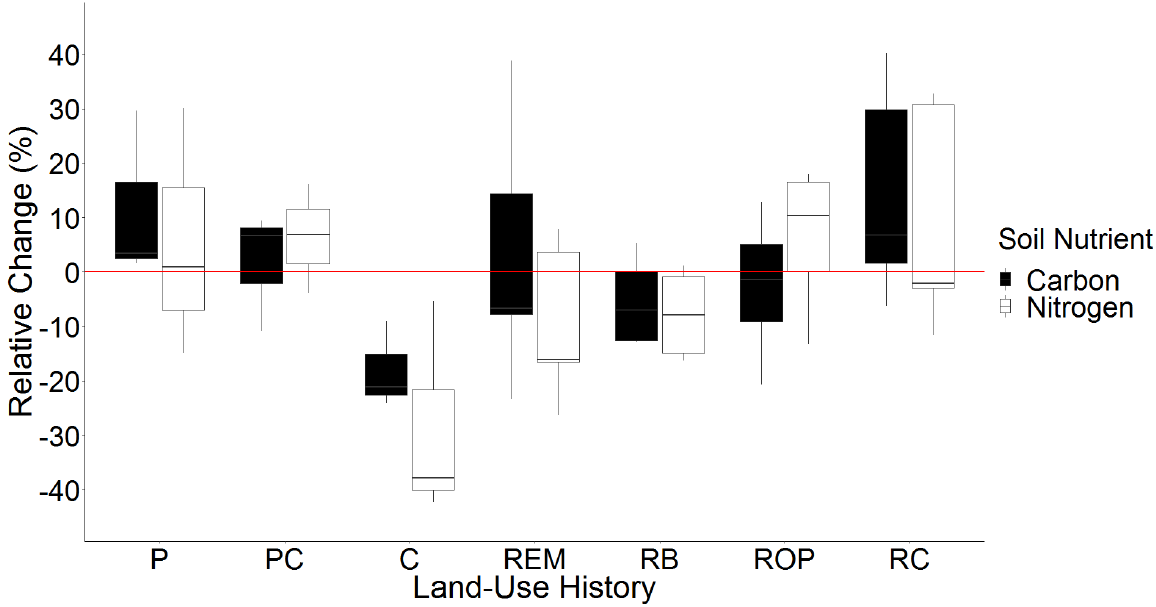
Figure 3. Relative change in g C kg⁻ 1 soil and g N kg⁻ 1 soil from 2008 to 2018 by land-use history. Red line indicates 0%. Land-use histories are cow pasture (P), cow pasture converted from row crop (PC), row crop fields (C), remnant prairie (REM), bison prairie restored from P and PC pastures (RB), prairie restored from old pasture (ROP), and prairie restored from row crop (RC).